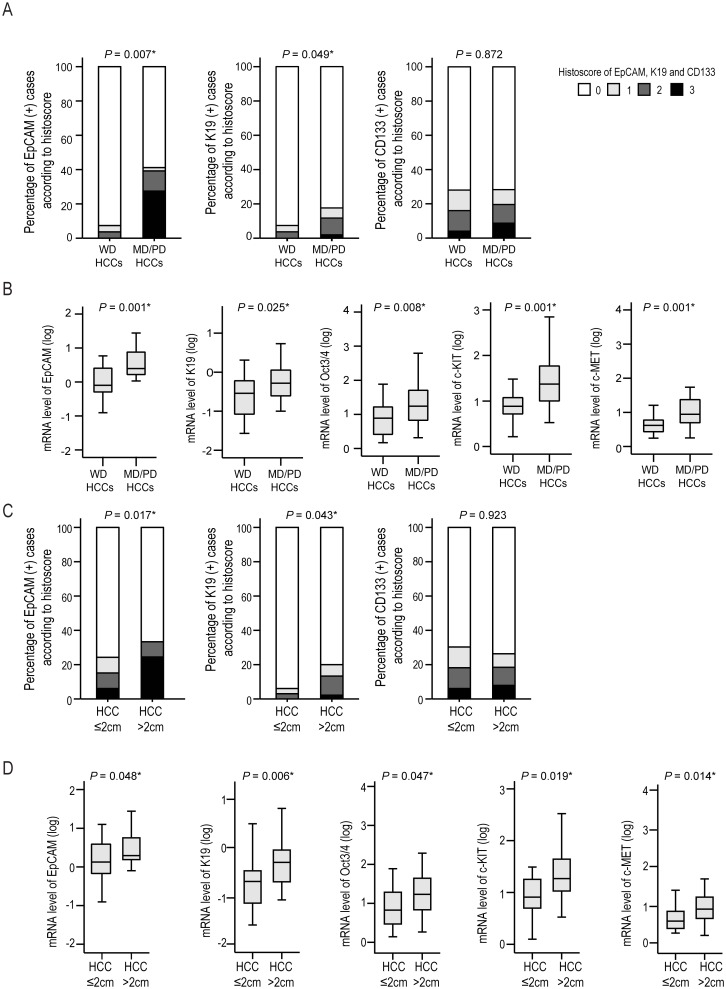
The expressions of stemness features according to differentiation (A, B) and size (C, D) of HCCs.Bar charts indicate the percentage of cases expressing EpCAM, K19 or CD133 protein. Box plots show the mRNA expression levels of EpCAM, K19, Oct3/4, c-KIT, and c-MET. *Statistical significance (P <0.05).